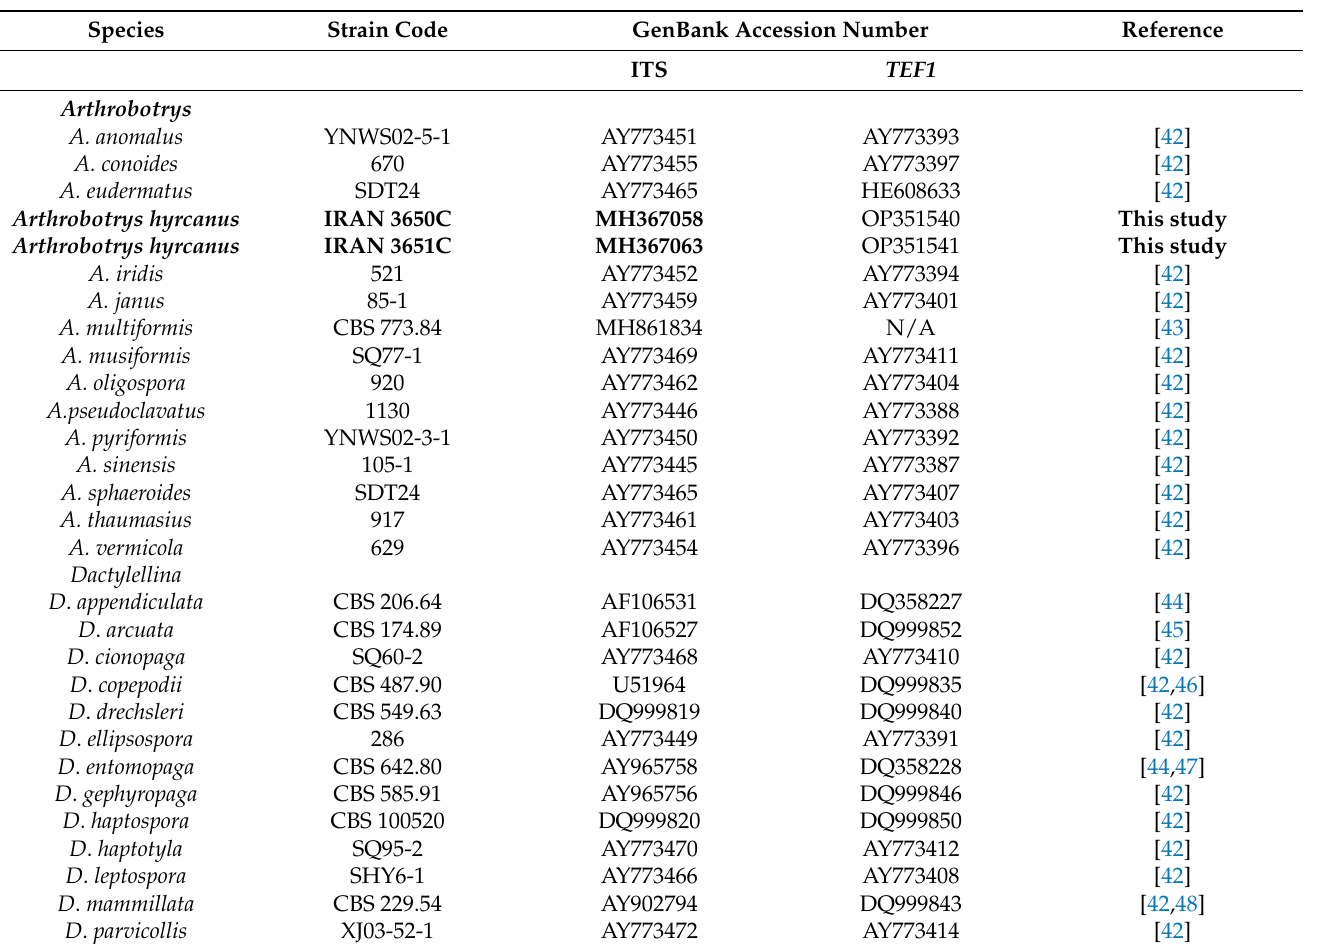
Table 1. Strain codes and GenBank accession numbers of sequences used in the phylogenetic analyses of Orbiliaceae. Isolates/sequences in bold were isolated/sequenced in the present study. N/A: not